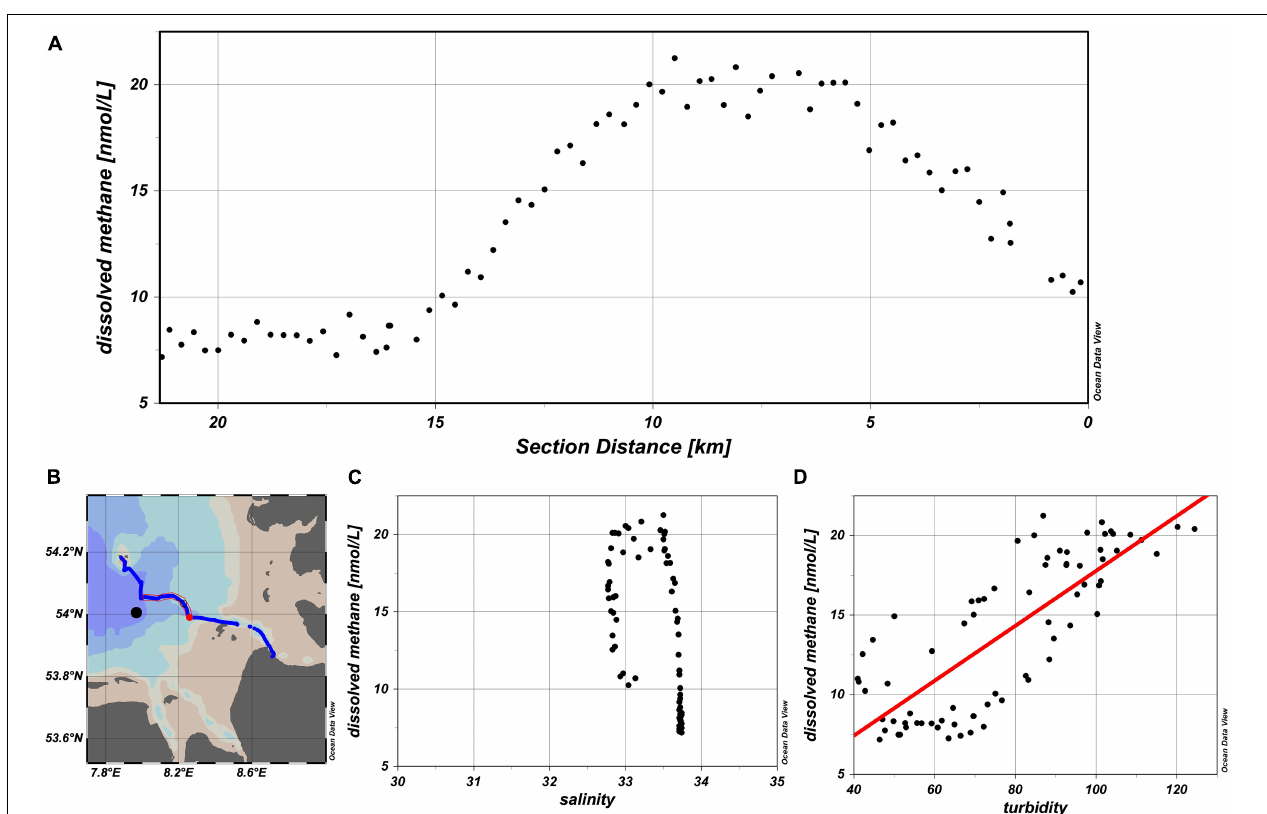
FIGURE 6 | A small-scale increase of methane (A) with the corresponding turbidity (D) in December 2018. The section is shown in (B) , and the section distance is recorded from east to west, starting with the red dot. Shown is also the correlation to salinity (C) .